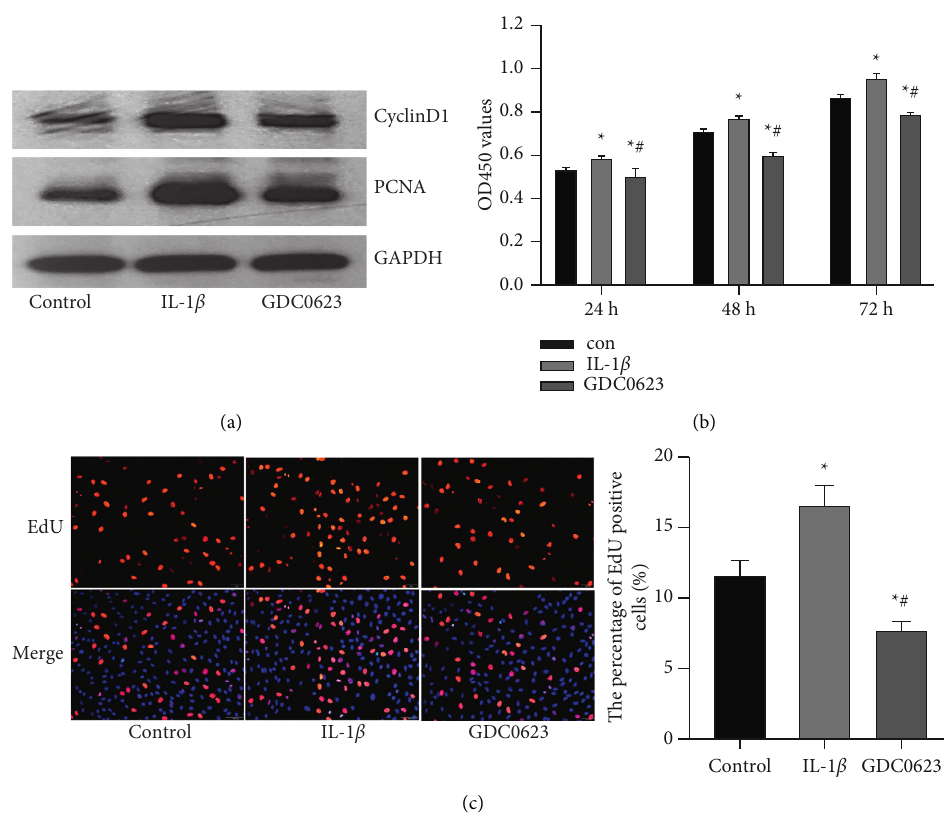
Figure 5: Effects of GDC0623 on osteoblast proliferation were evaluated by protein expression, CCK-8, and EdU staining assays. (a) Expression levels of PCNA and CyclinD1 were investigated by western blot. (b) Osteoblasts were treated with IL-1 β or IL-1 β plus GDC0623 for 24h, 48h, and 72h. Optical densities of the three groups at 450nm were determined and analyzed. (c) EdU incorporation assay of the three groups is on the left and statistical analyses of EdU positive cells are on the right. Data are expressed as mean ± SD for n � 3. ∗ p < 0.05 versus the control group, # p < 0.05 versus the IL-1 β